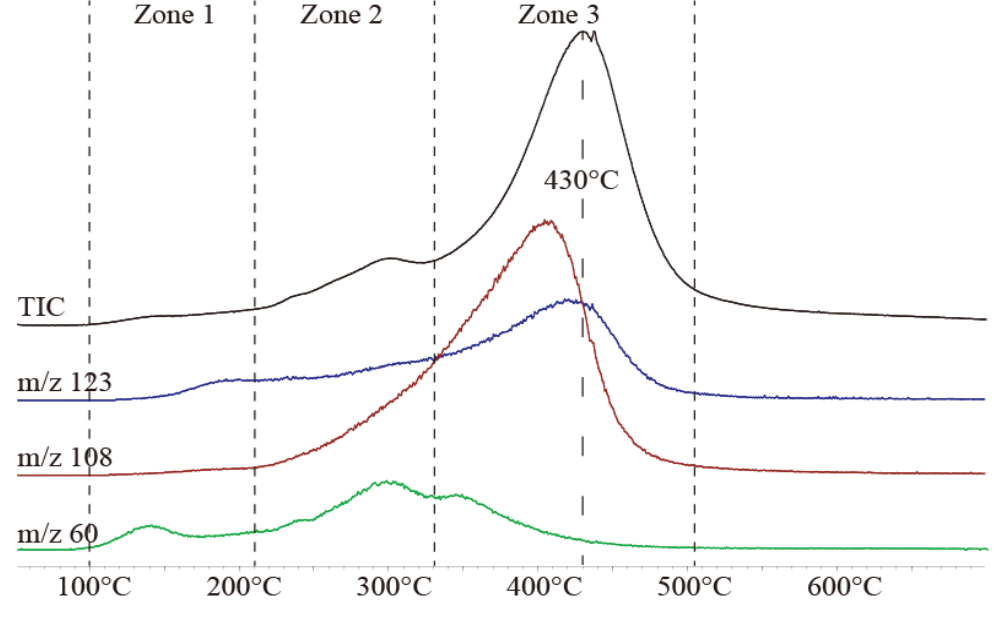
Figure 2. EGA charts of